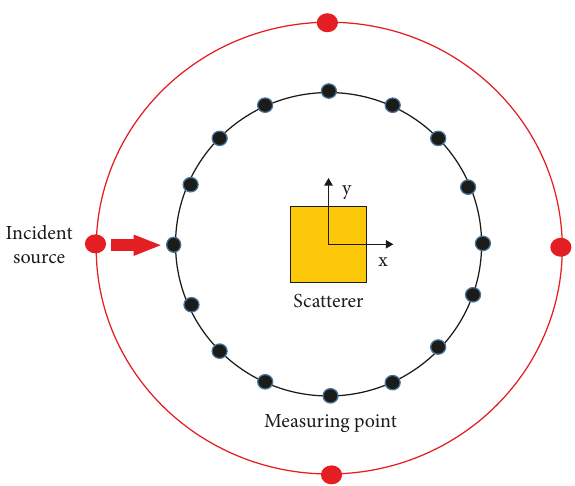
Figure 1: Traditional measurement model of microwave imaging.